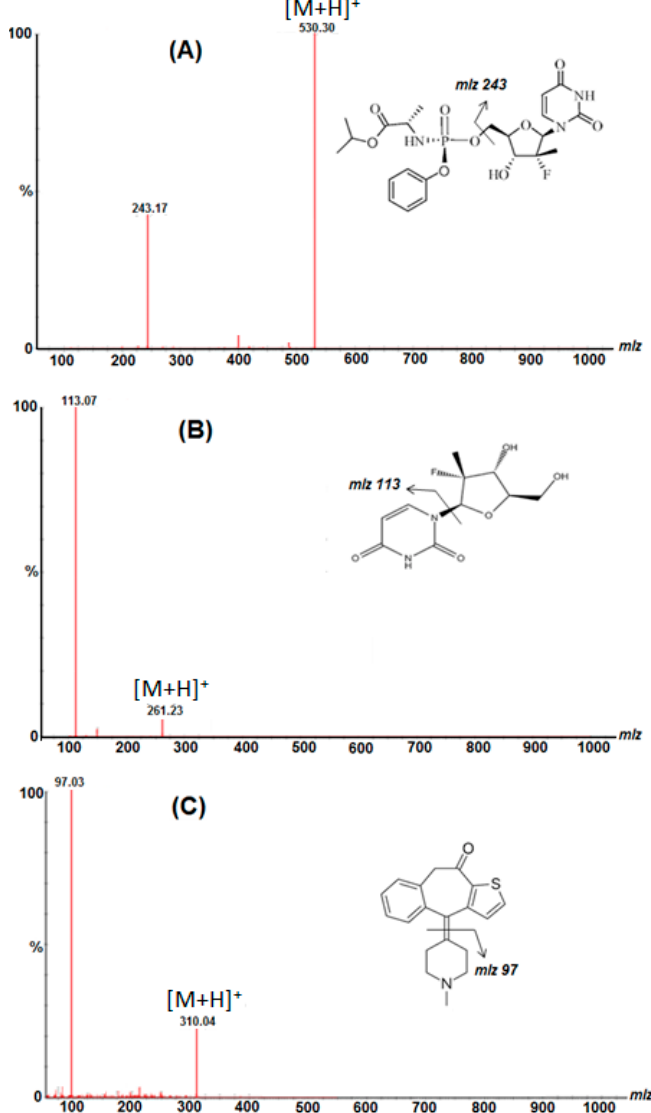
Figure 3. Structures, suggested fragmentation patterns and full-scan product ion spectra of sofosbuvir ( A ) , GS331007 ( B ) and ketotifen IS ( C ).